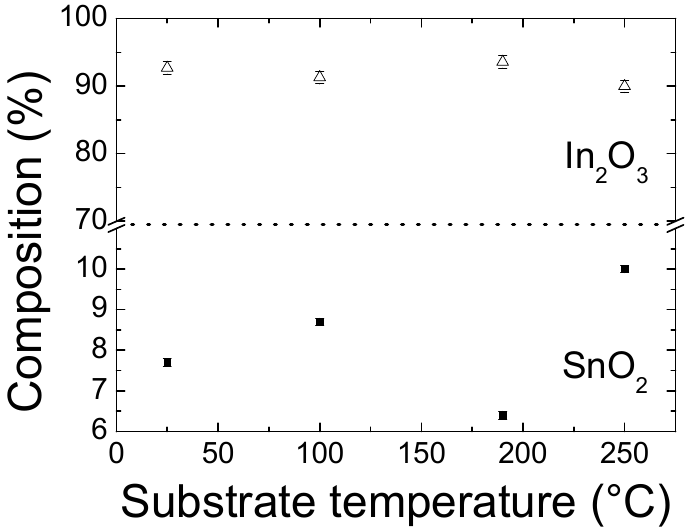
Figure 5. Compositional percentage of the In 2 O 3 and SnO 2 binary compounds estimated from WD ‐ XRF measurements.